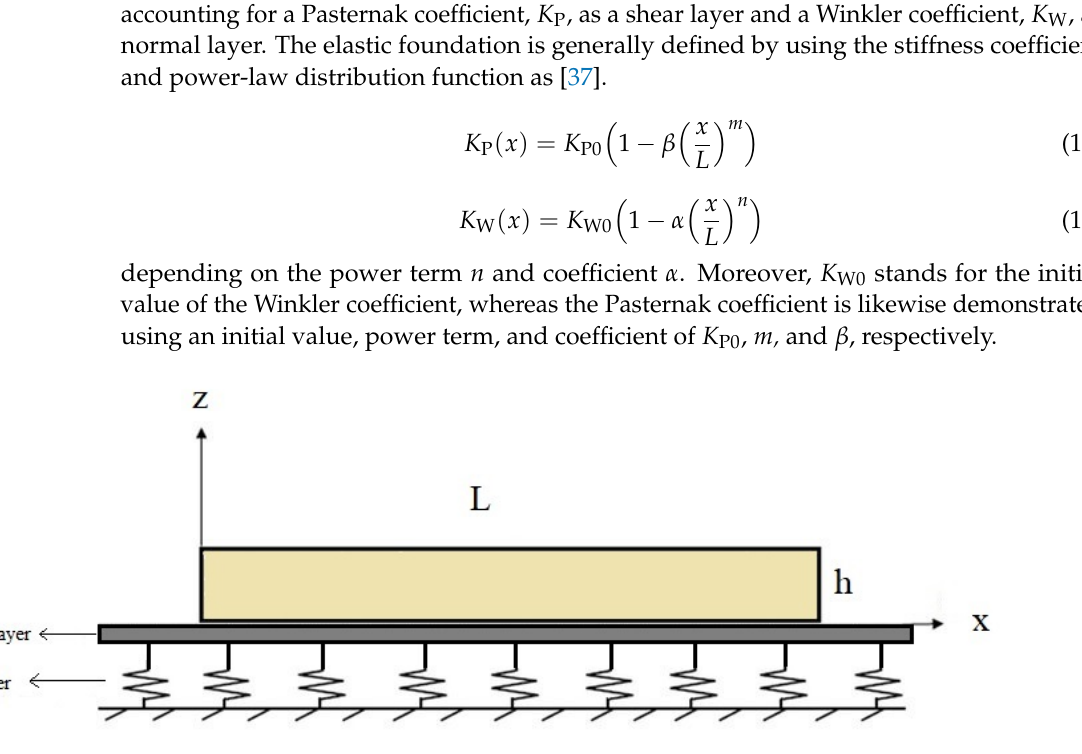
Figure 1. Geometrical model of composite beam on a Winkler-Pasternak foundation.